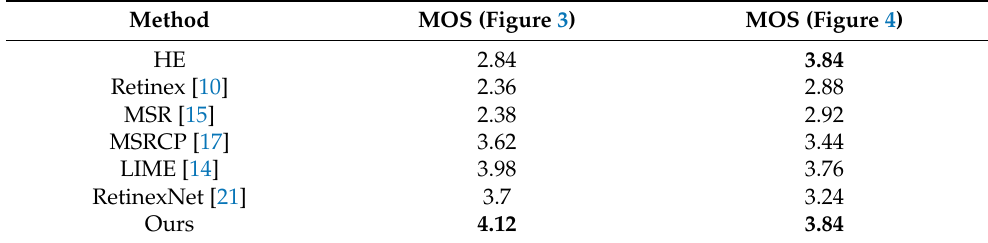
Table 2. MOS score table in Figures 3 and 4. The bold numbers indicate the best